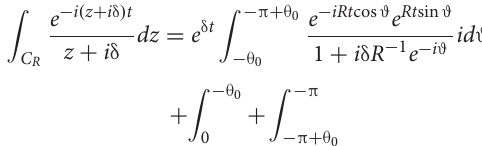
FIGURE 2 | The left part of the figure shows an archetypical spectrum of an operator, H, with the point spectrum σ P ( H ) along the negative real axis, denoted by “+,” and a simple continuous spectrum σ AC ( H ) along the positive real axis. For later use we have also indicated complex resonance eigenvalues in the lower complex plane as they appear in realistic physical cases. To the right we have inserted the spectrum of the corresponding Liouville equation (see Obcemea and Brändas, 1983). Here all the bound states pile together at the origin, while the associated resonances fall down on the negative imaginary